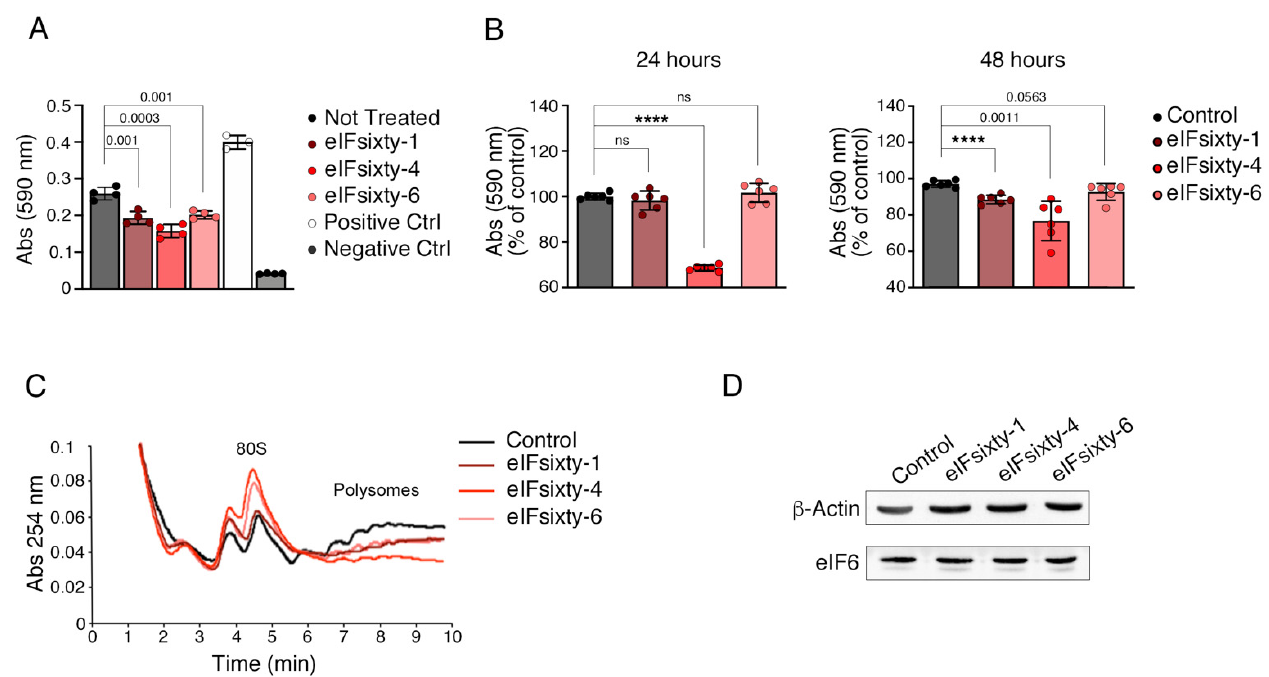
Figure 5. eIFsixty-i compounds inhibit eIF6-60S binding and impair the initiation of translation. ( A ) eIF6-60S binding is compromised in Huh7.5 cells upon eIFsixty-i treatment as shown by ELISA assay. The following concentrations were used: eIFsixty-1, 1.4 µ M; eIFsixty-4, 5 µ M; eIFsixty-6, 1 µ M. Positive control: recombinant eIF6 protein plus pure 60S ribosomes. Negative control: pure 60S ribosomes only in the reaction. Data are representative of three independent experiments. Results of two-tailed t tests are shown. ( B ) Histograms show cell viability of Huh7.5 cells at 24 and 48 h after addition of each eIFsixty-i compound, as indicated in ( A ). Data are represented as percentage of control (untreated). Results of two-tailed t tests are shown. **** p value ≤ 0.0001; ns indicates not significant. ( C ) Representative polysome profile for Huh7.5 cells treated with each eIFsixty-i compound (eIFsixty-1, 1.4 µ M; eIFsixty-4, 5 µ M; eIFsixty-6, 1 µ M). 80S and polysomes are indicated. Note that eIFsixty-i treatment impairs the initiation phase of translation, as shown by the increase in the 80S peak. ( D ) Western blotting: eIF6 protein levels are not reduced after 48 h of eIFsixty-i treatment.